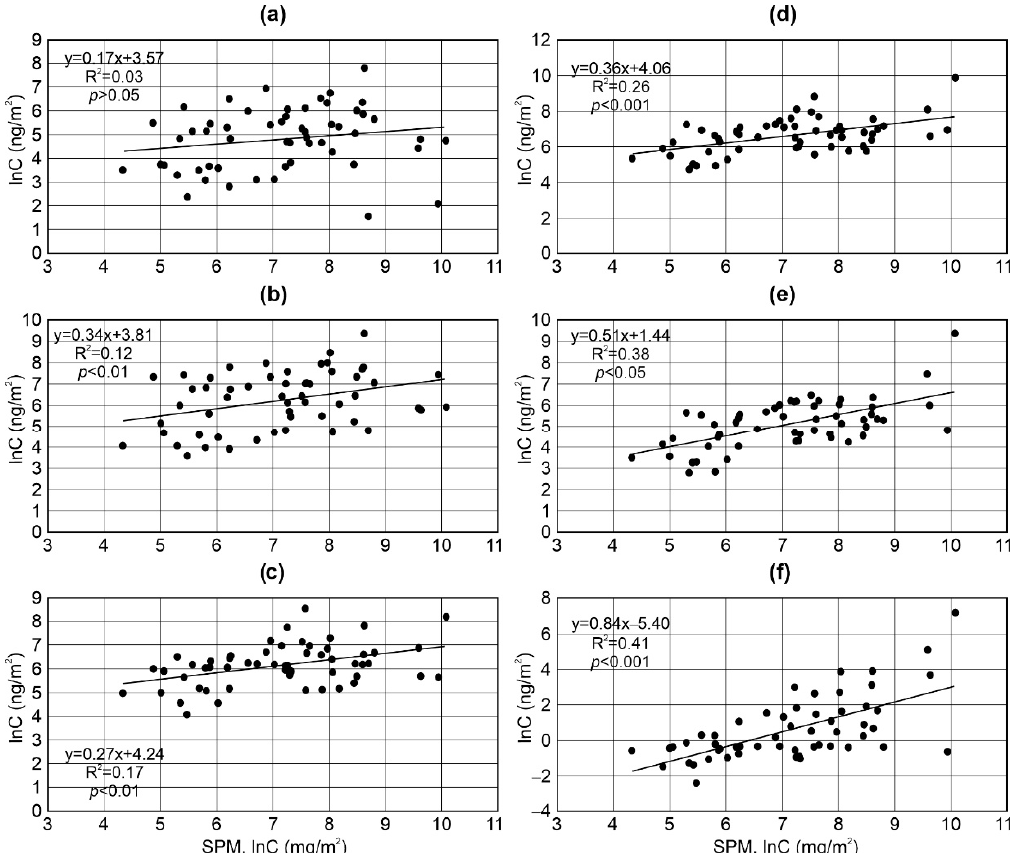
Figure 8. Relationship between the ln-transformed levels of suspended particulate matter (SPM) and PCB homologues (( a )—diCB; ( b )—triCB; ( c )—tetraCB; ( d )—pentaCB; ( e )—hexaCB; ( f )—heptaCB) in snow in the southern part of Irkutsk Region in 2021.